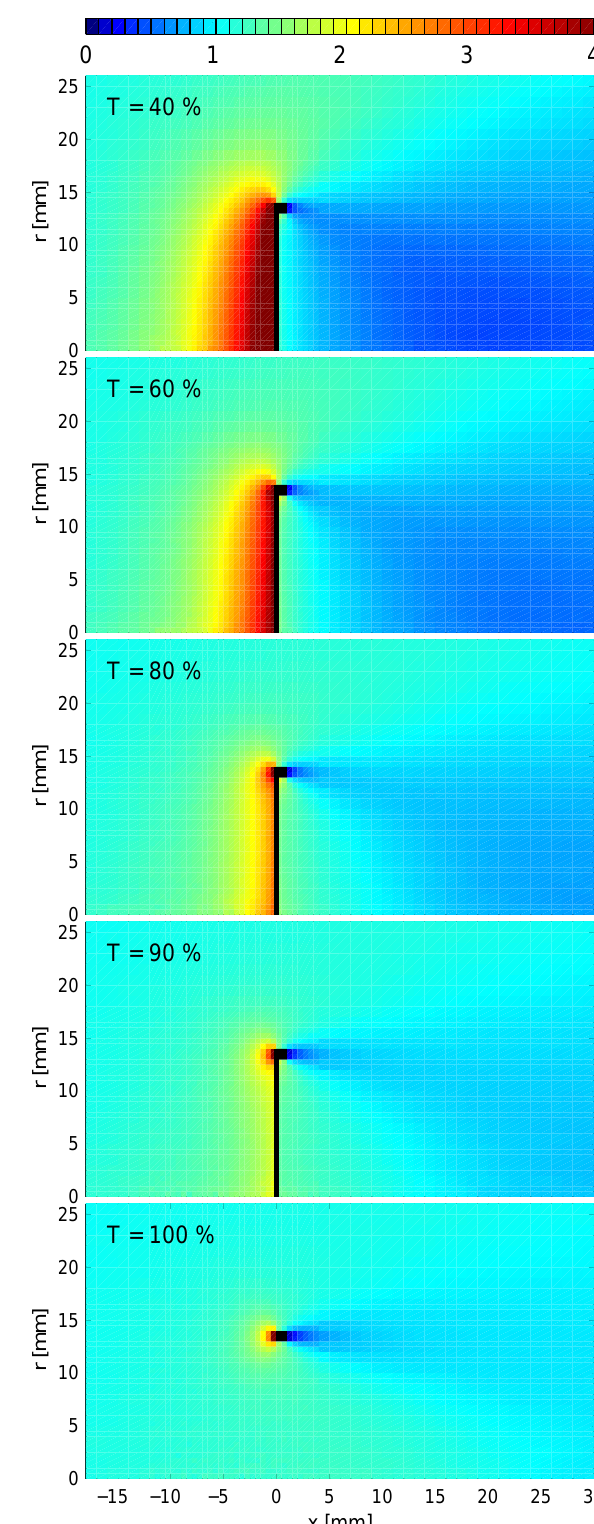
Fig. 4. Simulated density fields for meshes of different transmis- sivity and a molecular mean free path λ ∞ = 1 mm. Other flow parameters are c ∞ = 800 ms − 1 and T ∞ = 180 K.